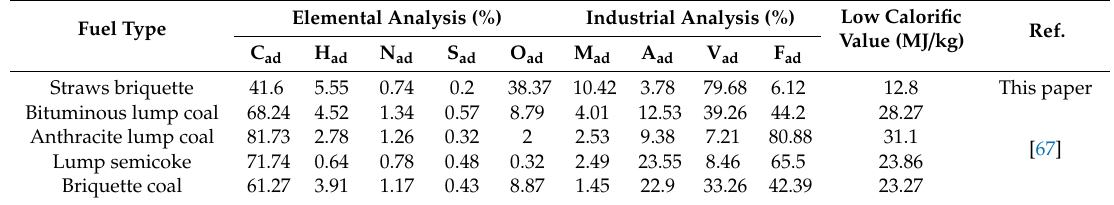
Table 7. Elemental analysis, industrial analysis, and calorific value of straw blocks and agricultural